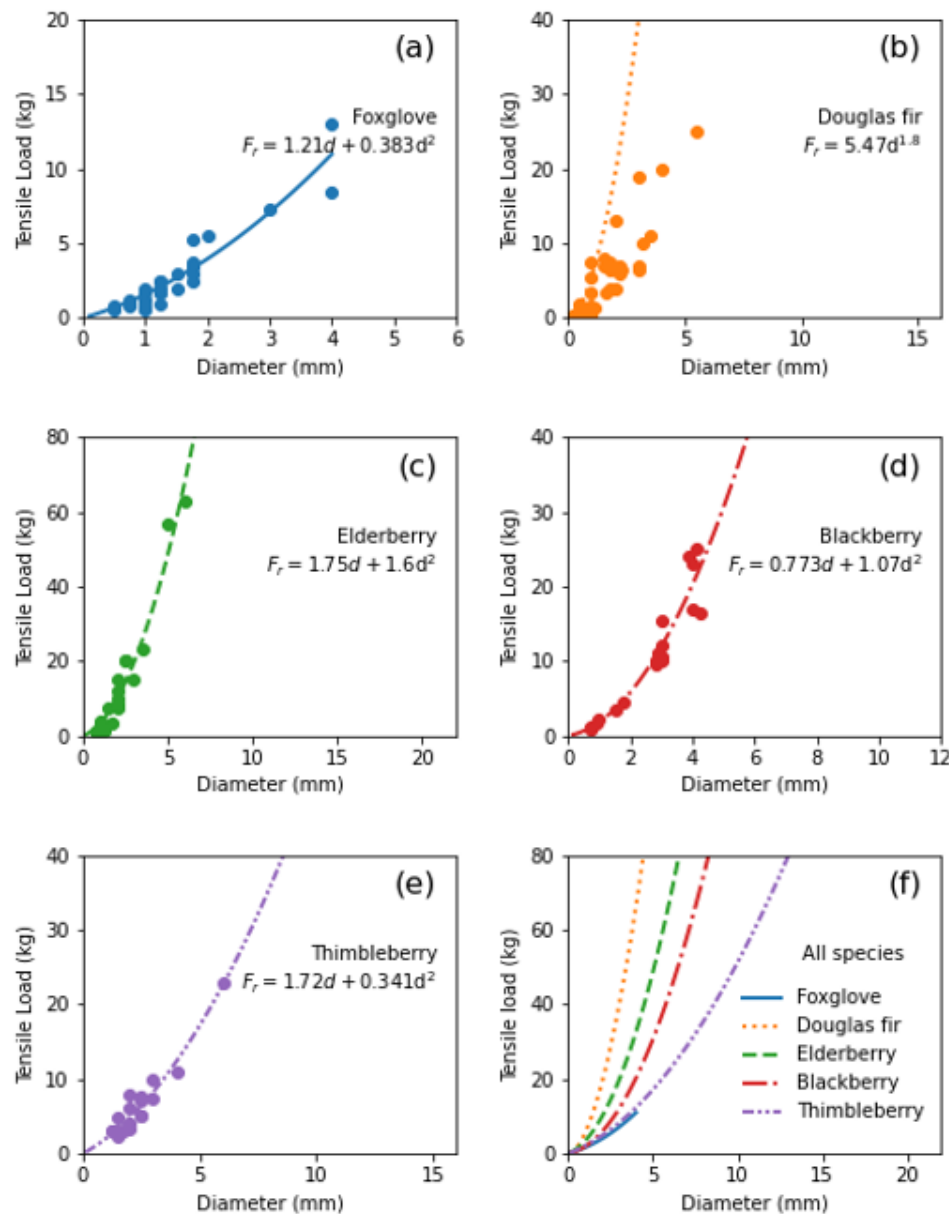
Figure 3. Field-measured relations of species type with tensile load at failure (solid circles) for a given thread diameter with best fit second-order polynomial model from Equation (A1) (see Appendix A) (except for Douglas fir, where the equation of Burroughs and Thomas [37] was used). Equations are shown for foxglove ( a ), Douglas fir ( b ), elderberry ( c ), blackberry ( d ), and thimbleberry ( e ). Panel ( f ) shows the estimated curves for all species color-coded by the individual species. In all plots, the diameter range of the curves represents the range over which the tensile load was estimated. All data are available in Schmidt and Cronkite-Ratcliff [35].